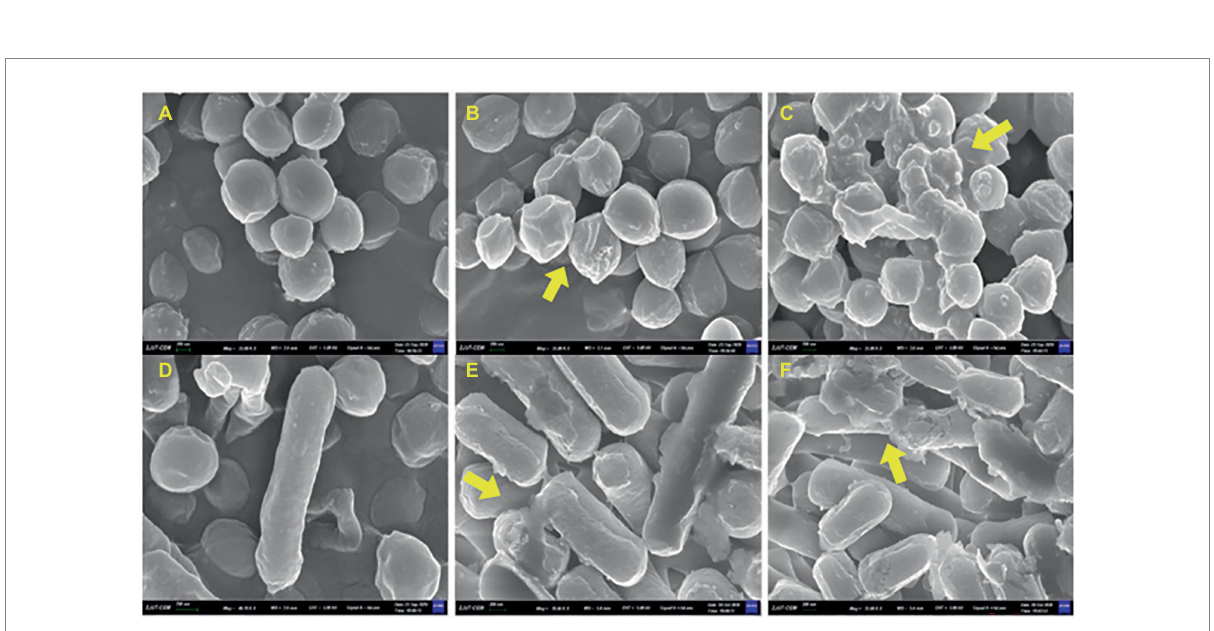
FIGURE 5 FEGSEM image of S. xylosus and L. plantarum . (A) S. xylosus untreated; (B) S. xylosus treated with MDA at MIC; (C) S. xylosus with MDA at 2MIC; (D) L. plantarum untreated; (E) L. plantarum treated with MDA at MIC; (F) L. plantarum with MDA at